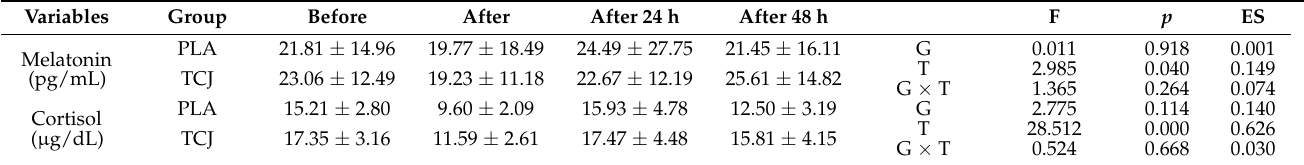
Table 2. Change in melatonin and cortisol levels according to the intake of tart cherry